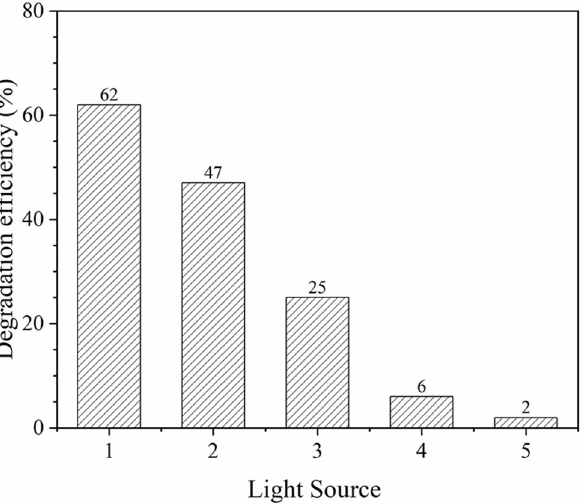
Figure 9. Impact of light source on photocatalytic degradation efficiency (1: UV ‐ C; 2: Xe ‐ lamp; 3: Sunlight simulator; 4: UV ‐ A; 5: LED; m POF/TiO2 = 50 mg; c POF/TiO2 = 1 g/L, [Phenol] 0 = 50 mg/L; V phenol = 50 mL; pH = 6.7, t = 4 h).